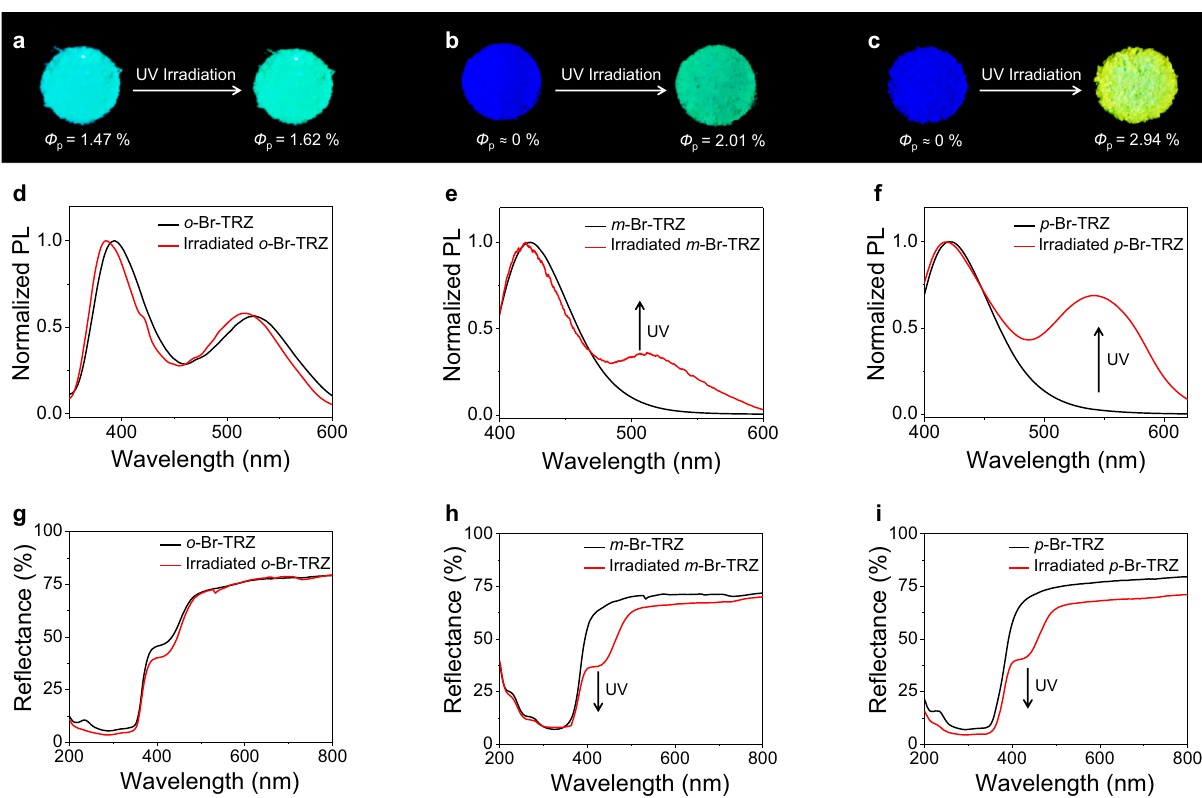
Fig. 2 Photophysical properties of designed triazine derivatives. Photos showing photoluminescence of ( a ) o -Br-TRZ, ( b ) m -Br-TRZ, and ( c ) p -Br-TRZ, before and after UV irradiation (365 nm LED, 516 mW/cm 2 ) for 90 s, with the change of phosphorescence quantum yield ( Φ p ). Photoluminescence spectra of ( d ) o -Br-TRZ, ( e ) m -Br-TRZ, and ( f ) p -Br-TRZ, before and after UV irradiation (365 nm LED, 516 mW/cm 2 ) for 90 s. In addition to the intrinsic RTP of o -Br-TRZ, RTP of m -Br-TRZ and p -Br-TRZ can be triggered by UV irradiation. UV-Vis diffuse re fl ectance spectra of ( g ) o -Br-TRZ, ( h ) m -Br-TRZ, and ( i ) p -Br-TRZ, before and after photoactivation under ambient conditions.